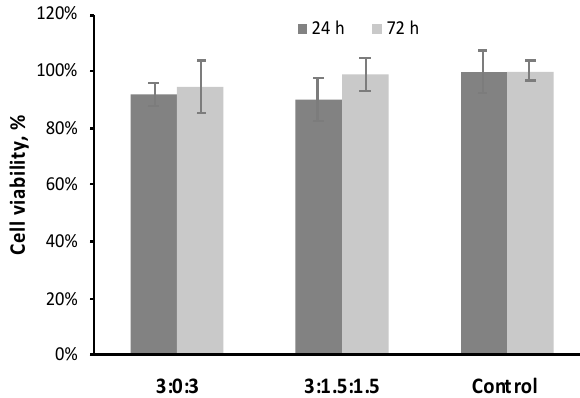
Figure 9. Cell viability of pre-osteoblast cells (MC3T3–E1) after 24 h of exposure to the 24-hour and 72-hour extracts of hydrogels at ratios 3:0:3 and 3:1.5:1.5. MEM– α culture medium was used as a control. No statistically significant difference was found between any hydrogel and control ( p > 0.05).